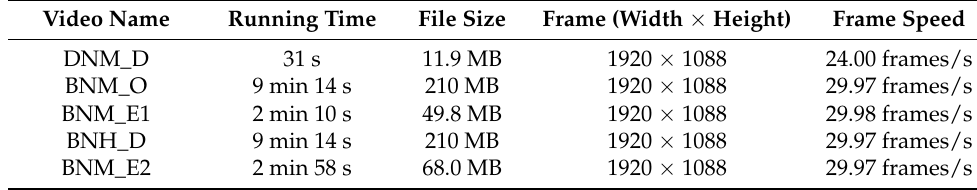
Table 9. Videos in suspect’s smart phone (scenario